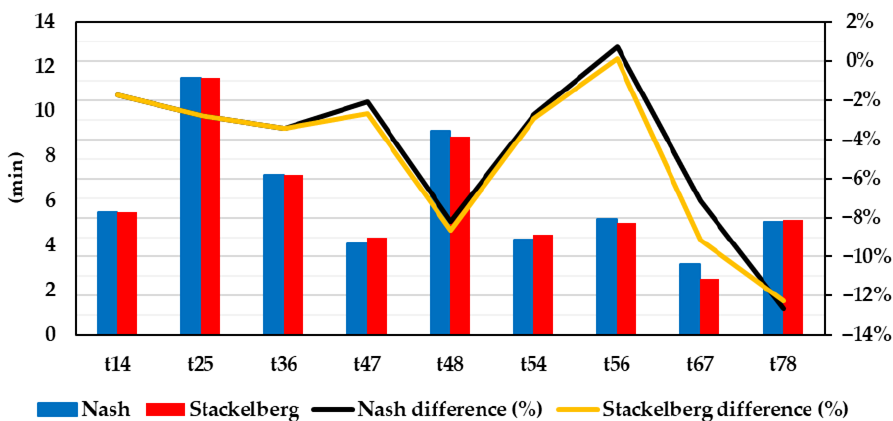
Figure 8. Compared travel times through individual links to road network for scenario #2. (Nash and Stackelberg differences (%) represent the percentage increase in travel time through each link compared to the results of scenario #1).